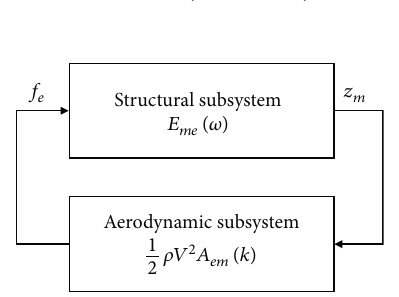
Figure 3: Aerodynamic subsystem.